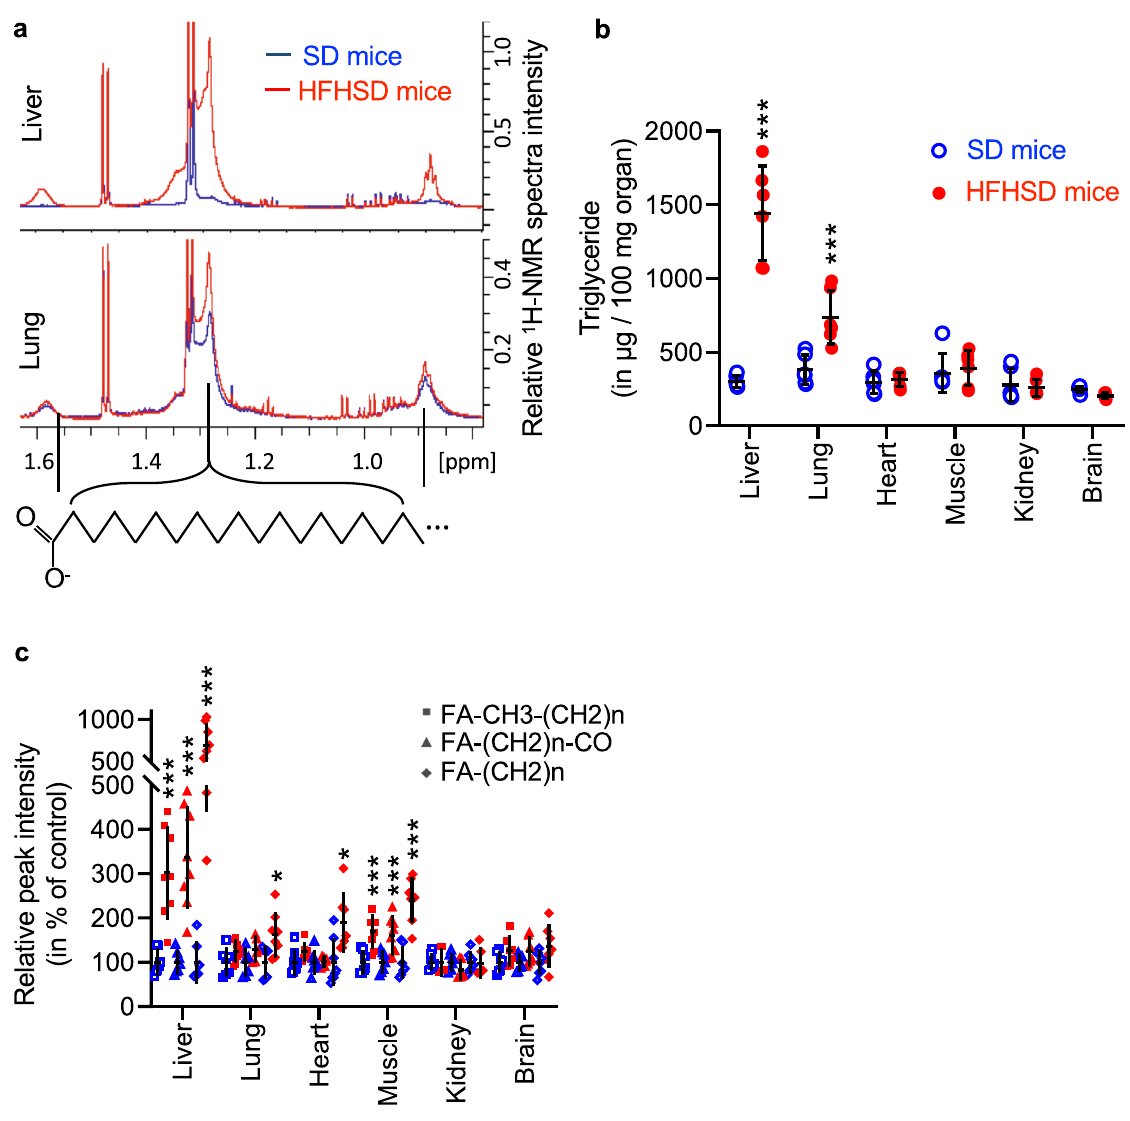
Figure 2. Lipids and specifically triglycerides accumulation in the lung in comparison with the liver or all other organs of SD and HFHSD mice. ( a ) 1 H-NMR representative spectra from the lung (at bottom) and the liver (at top) from SD (blue) and HFHSD (red) fed mice. Spectra zoom highlights fatty acid (FA) areas of –C H 2 –CO (1.6 ppm), (C H 2 –CO (triangle), (C H 2 )n (diamond) and CH 2 –C H 3 (square) of SD (blue empty) or HFHSD (red full) fed mice estimated by integration of the 1 H-NMR spectra. Data are mean of n = 8 mice per group; Results of unpaired two-tailed t-test are indicated as non-significant (NS) p < 0.05 (*), p < 0.01 (**), p < 0.001 (***) and p < 0.0001 (****). ( c ) Triglyceride contents in liver, lungs, heart, gastrocnemius muscles, kidneys and brain. Data are mean of n = 8 mice per group; Results of unpaired two-tailed t-test are indicated as non-determined (ND), non-significant (NS), p < 0.05 (*), p < 0.01 (**), p < 0.001 (***) and p < 0.0001 (****). (The quantification is also reported in μg/mg of total protein in Supplementary Fig. Obesity‑associated metabolic signatures in serum and other organs. NMR analyses of serum showed that glucose concentration increased by 31% in HFHSD mice compared to SD mice, varying from 3.82 ± 1.16 to 5.01 ± 0.55 mM (p < 0.02, Table 3, n = 8 per group), in agreement with the glycemia measurement using a glu- cometer (Table 1). NMR analyses also evidenced lower serum concentrations for allantoin, creatine and pheny- lalanine, and higher concentrations for alanine and 3-hydroxybutyrate in HFHSD-fed mice compared to con- trols (p < 0.05, Table 3). Citrate and succinate concentrations, two TCA-derived metabolites, were 28% and 32% higher in the serum of HFHSD-fed mice compared to controls, respectively (p < 0.02). Inversely, glycine, dimeth- ylglycine (DMG) and betaine that derive from the 1C cycle metabolism were 34%, 68% and 54% lower in the serum of HFHSD-fed mice compared to controls, respectively (p < 0.01). No significant alteration of branched- chain amino acid concentrations was observed in serum (Table 3).